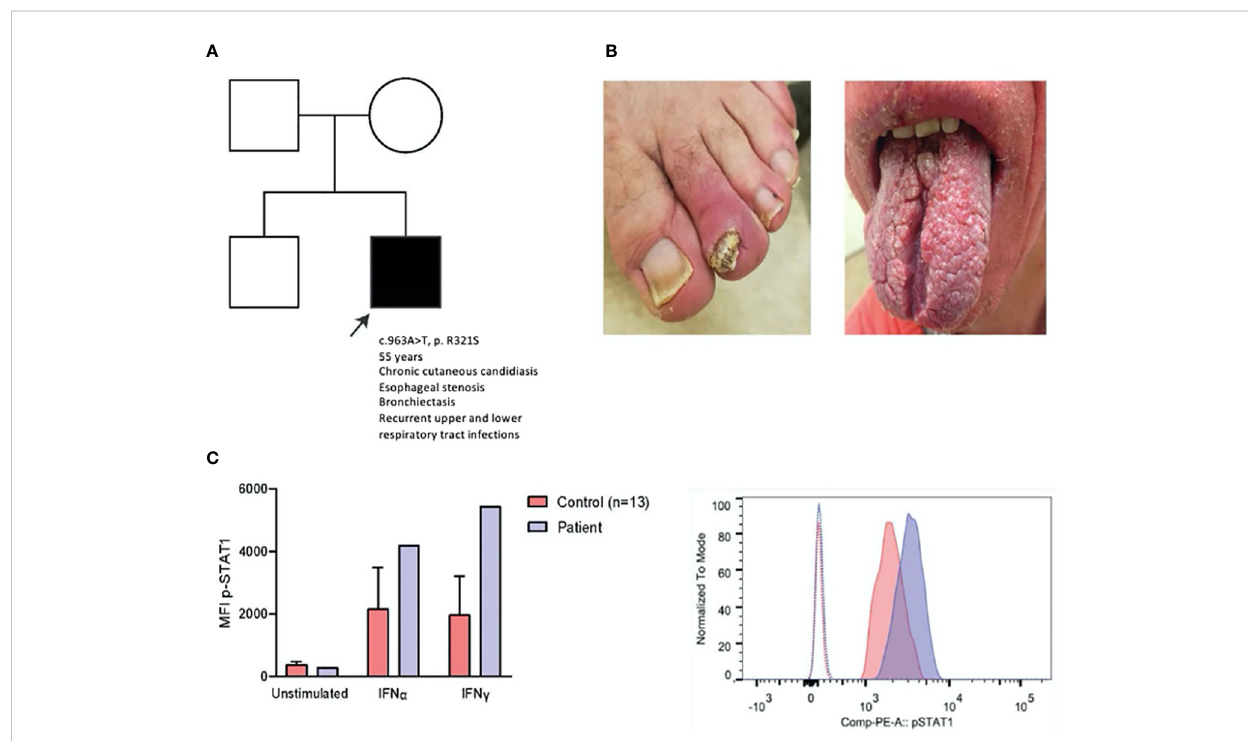
FIGURE 1 Clinical, genetic and laboratory fi ndings in a patient with STAT1 GOF. (A) Patient pedigree. c.963A>T was demonstrated using Sanger sequencing (data not shown), (B) Clinical pictures of onychomycosis (left) and impact of CMC on the tongue (right), (C) p-STAT1 MFI of patient and age- matched controls (n=13) on CD14 + monocytes unstimulated and after IFN a (2000 IU/ml) and IFN g (2000 IU/ml) stimulation for 15 minutes (left); representative histogram of p-STAT1 on CD14+ monocytes in patient and healthy control (right) after IFN- g stimulation (15 min). MFI: mean fl uorescence